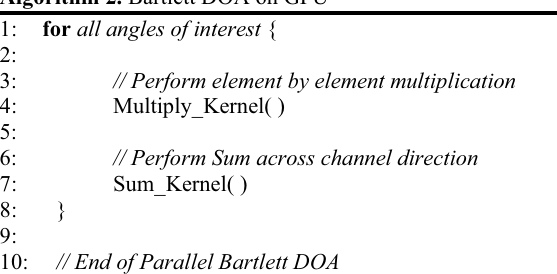
Algorithm 2. Bartlett DOA on GPU